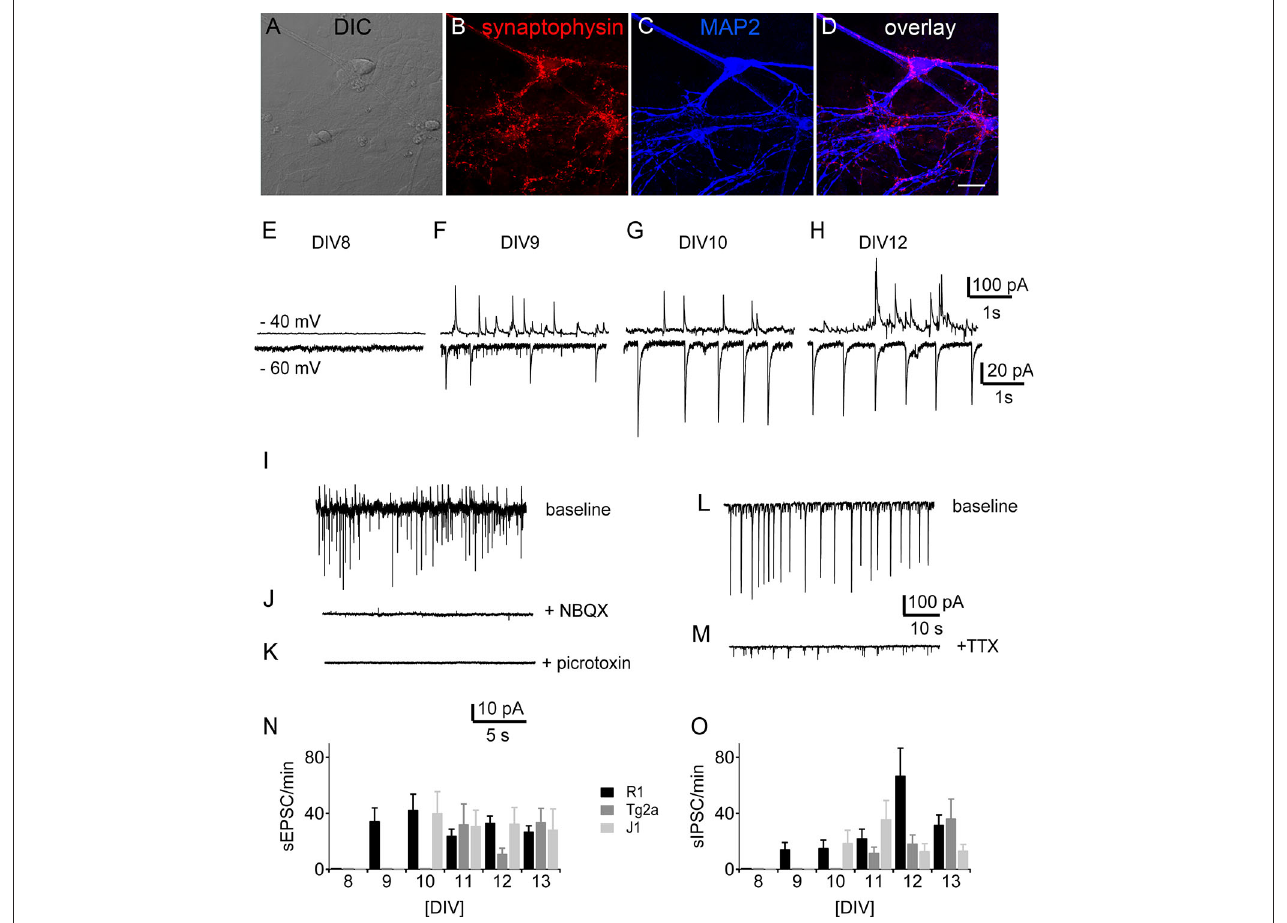
synaptic currents. (I) Sample trace of one experiment with baseline recording (J) after bath application of NBQX (10 µ M) and (K) bath application of picrotoxin (100 µ M). (L) Sample trace of spontaneous synaptic activity under control conditions and (M) after the application of TTX (1 µ M). (N) Frequency of sEPSCs as a function of DIV for neurons derived from R1 (black), T2ga (gray) and J1 (light gray) mES cells in cultures from DIV 8–13. (O) Same data for